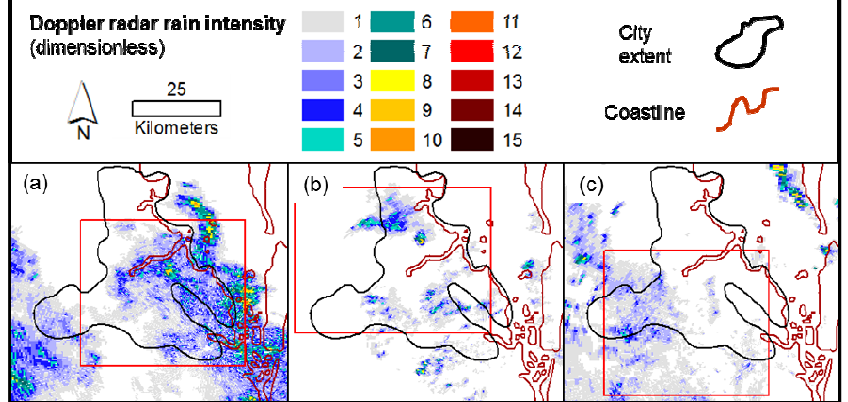
Figure 5. BoM Mt Staplyton Doppler rain radar dimensionless rain intensity: ( a ) Sc2009, 2Dec09 03:48 UTC; ( b ) Cu/Sc2010, 25Sep10 03:40 UTC; and ( c ) St2011, 23Nov11 23:00 UTC showing the geostatistics sample grid extent for